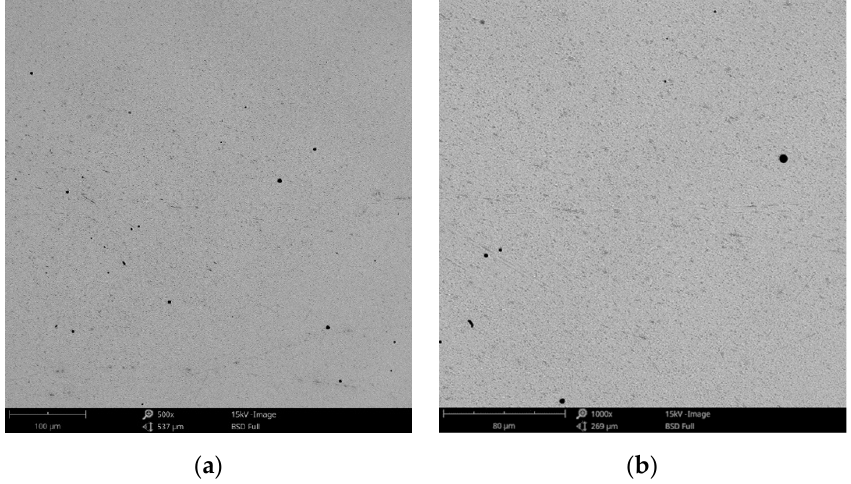
Figure 17. SEM images of the CCm-7 sample after corrosion tests at ( a ) 300×; ( b ) 500×.